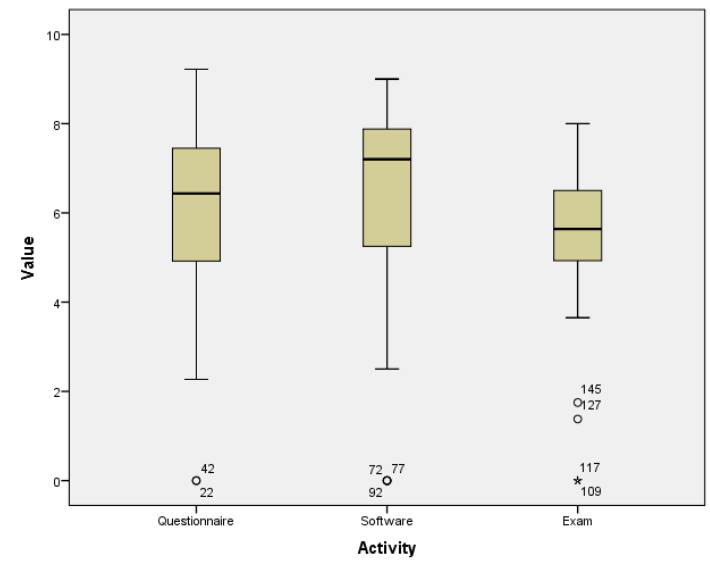
Figure 16. Box plot for the assessment activities results in the academic year 2018–2019.